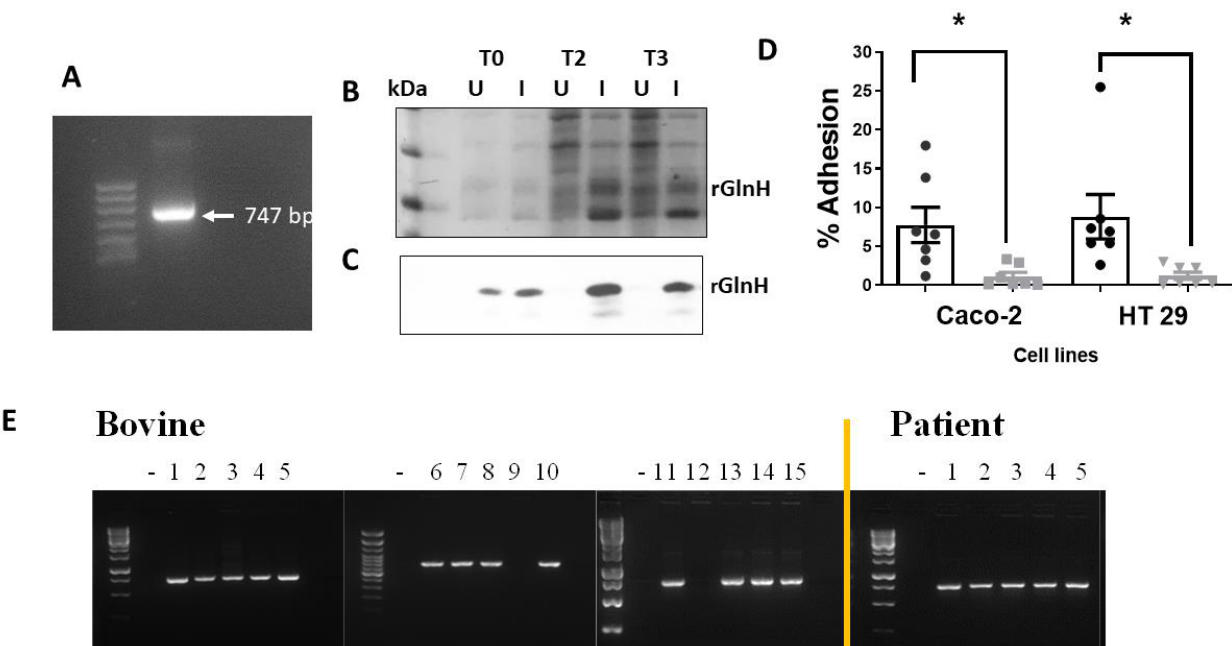
Figure 2. Effect of expression of GlnH on host cell attachment and prevalence of glnH gene in bovine and human patient isolates. ( A ) The glnH gene was cloned into BL_21 cells and its presence confirmed by PCR analysis, identifying an amplicon at 747 bp. Expression of GlnH in BL21 cells after 3 h induction with IPTG (1 mM) was confirmed by SDS-PAGE gel stained with Page Blue TM ( B ) and Western blot using an anti-His-tag antibody ( C ). ( D ) Expression of GlnH protein increased the level of bacterial attachment to gastrointestinal cells compared to uninduced BL21 cells in vitro. The level of attachment of induced (black) and uninduced (grey) BL21 cells recombinantly expressing protein GlnH to gastrointestinal cells (HT29 and Caco-2). Each error bar represents mean ± SEM from four independent experiments. Black bars represent induced BL21_ glnH cells, and grey bars represent BL21_ glnH cells that were not induced. Differences in % adhesion were analysed by one-way ANOVA with Sidak’s multiple comparison test (*, p < 0.05). ( E ) Presence of the glnH gene identified in VTEC isolates from 15 bovine and 5 human patient isolates, as determined by PCR amplification and visualisation on 2% agarose